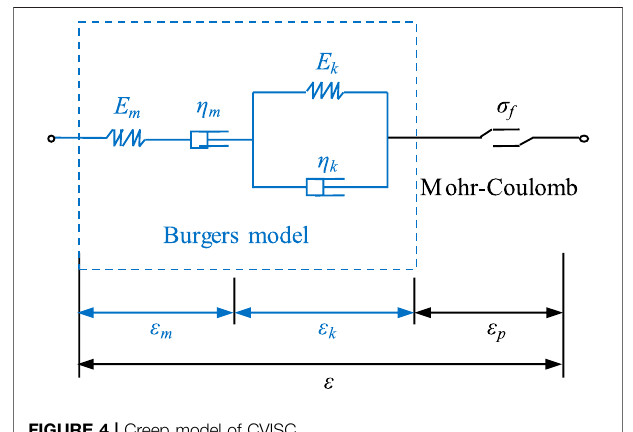
FIGURE 4 | Creep model of